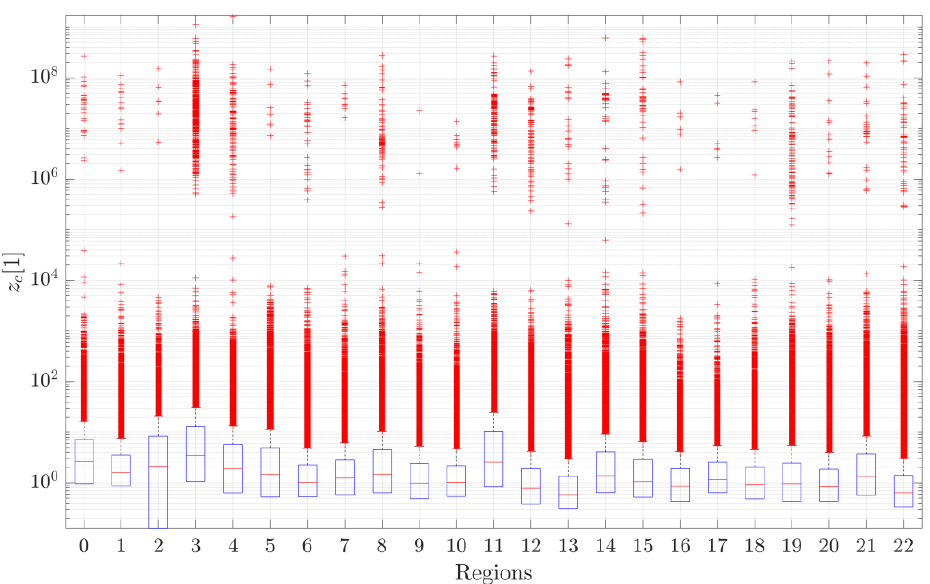
Figure 17. Regional statistics of z c along GB coastline. The central mark indicates the median, and the bottom and top edges of the box indicate the 25th and 75th percentiles, respectively. The whiskers extend to the most extreme data points not considered outliers, and the outliers are plotted individually using the “ + 2” symbol. To obtain these stats, we did not include clusters that corresponded with non-cli ff coastlines (Clusters 1, 5 and 8) and 4% of other clusters that had H c ,0 < 0 and S 0 ≥ 0. We used Equation (20) and assumed a shoreface slope representative of GB’s open coast to be equal to 10 − 3 . See Table S1 for correspondence between region number and admin unit used.